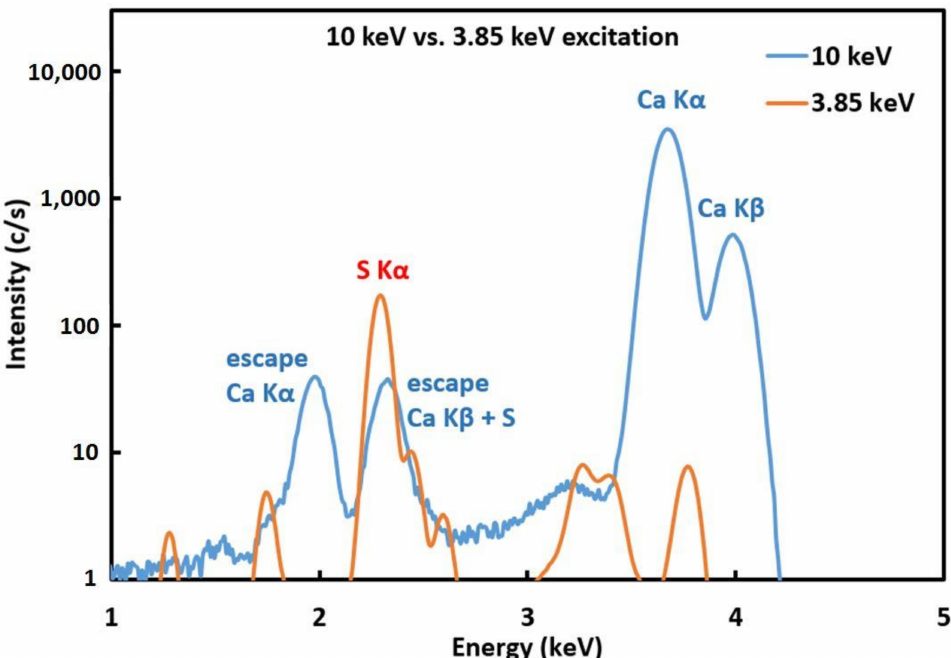
Figure 2. Comparison of XRF spectra on Carrara marble samples obtained with 3.85 keV and 10 keV excitation